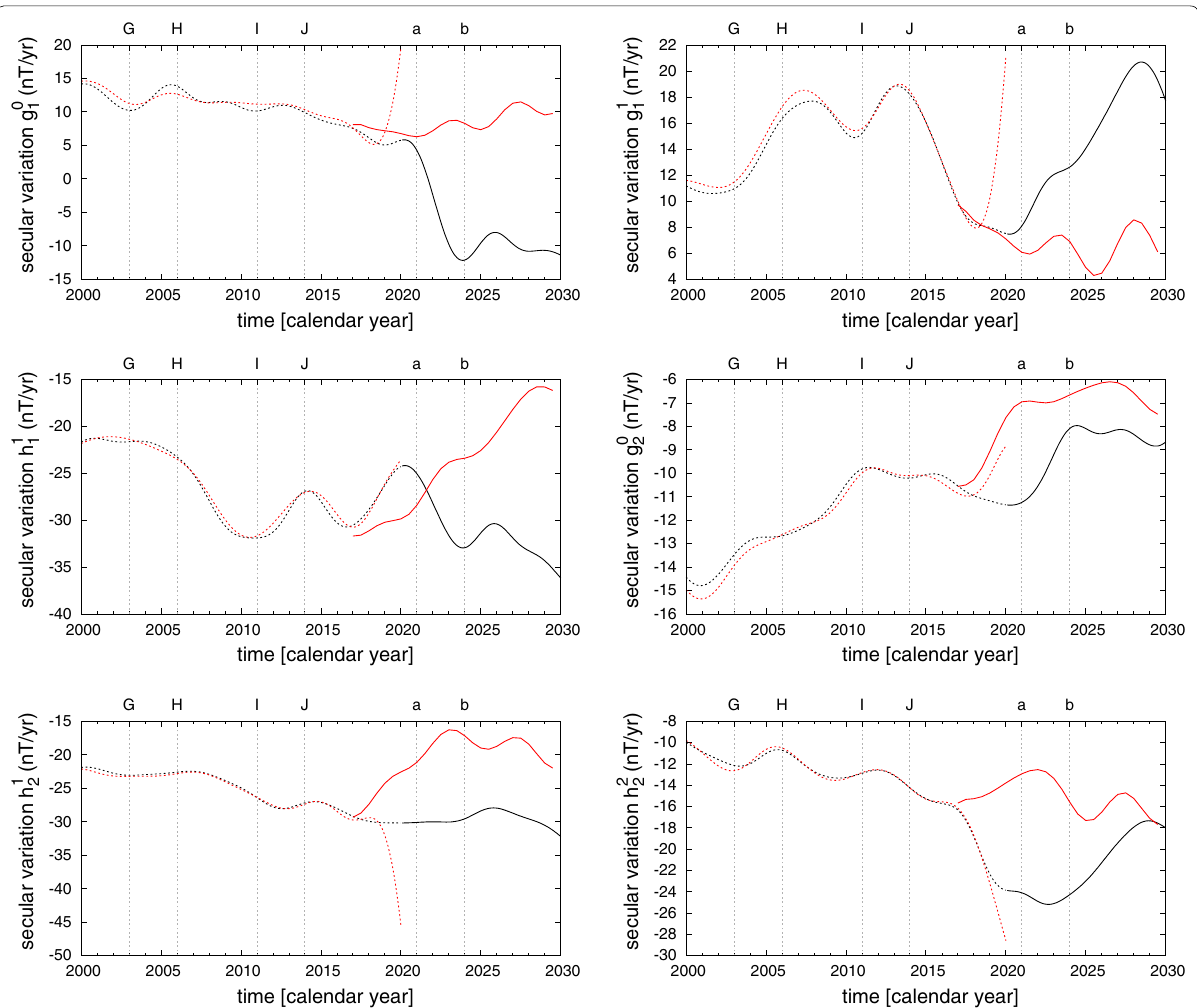
Fig. 8 Comparison of six observed and predicted secular variation coefficients with the largest amplitude at Earth’s surface. Model 1 (dashed black line), Model 2 (dashed red line) and their forecasts (solid lines). Vertical lines labeled with a and b mark two possible geomagnetic jerks. The other labels mark occurrences of known